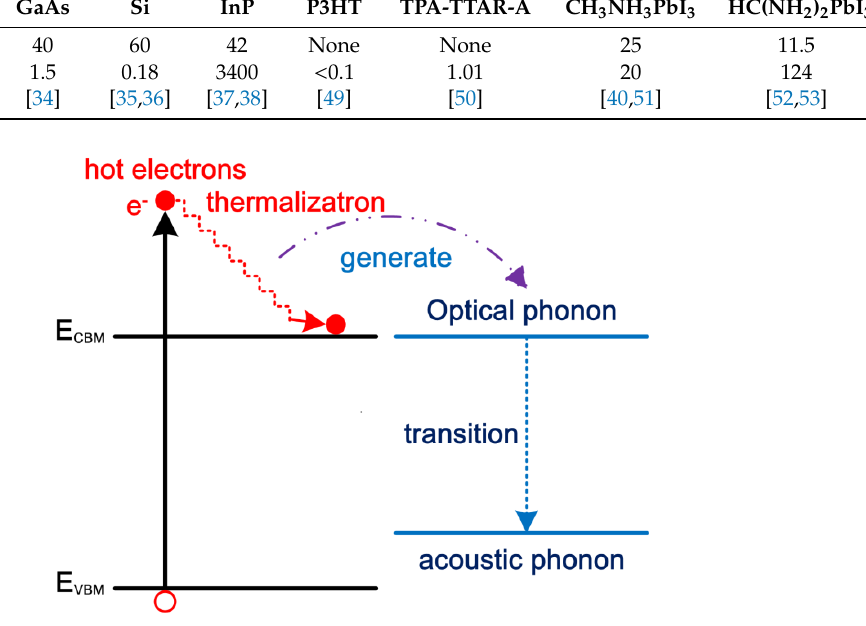
Figure 2. Hot carrier-optical phonon energy transfer and thermalization process.